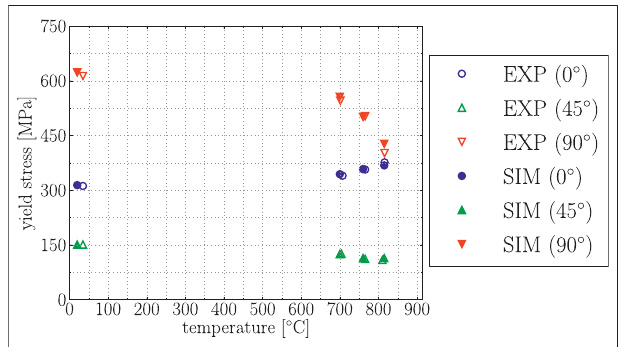
FIGURE 6 | Yield stress ( σ 0 . 2 ) of differently oriented PST crystals. Comparison of simulation results to experiments from Parthasarathy et al. (2000).